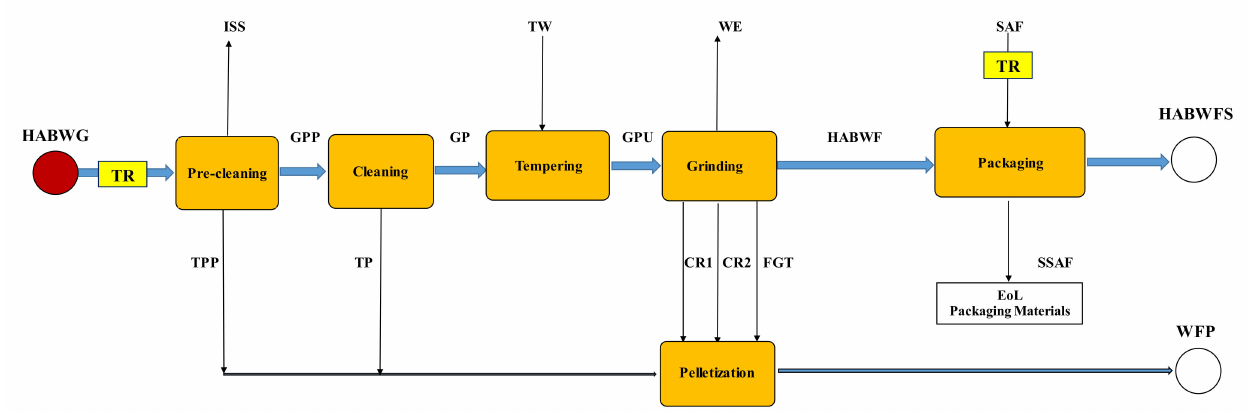
Figure 2. Block diagram of the high-amylose bread wheat milling process carried out in the pilot-scale miller at Grandi Molini Italiani SpA (Venice, Italy). All symbols are listed in the Nomenclature section.